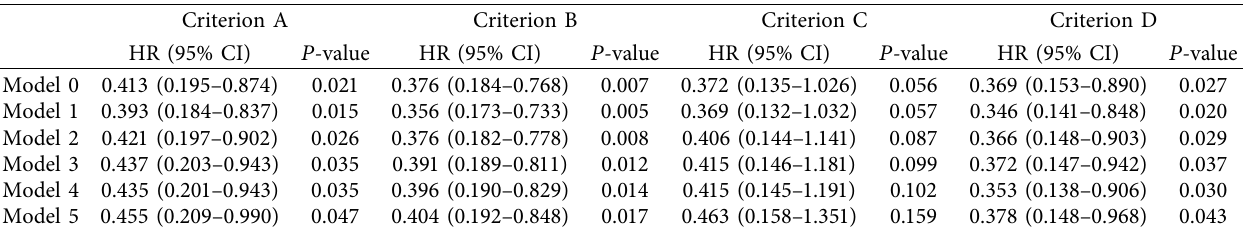
Table 2: Crude and adjusted hazard ratios (HR) with 95% confidence intervals (CI) of amniotic membrane transplantation for surgical failure according to the four different success criteria.